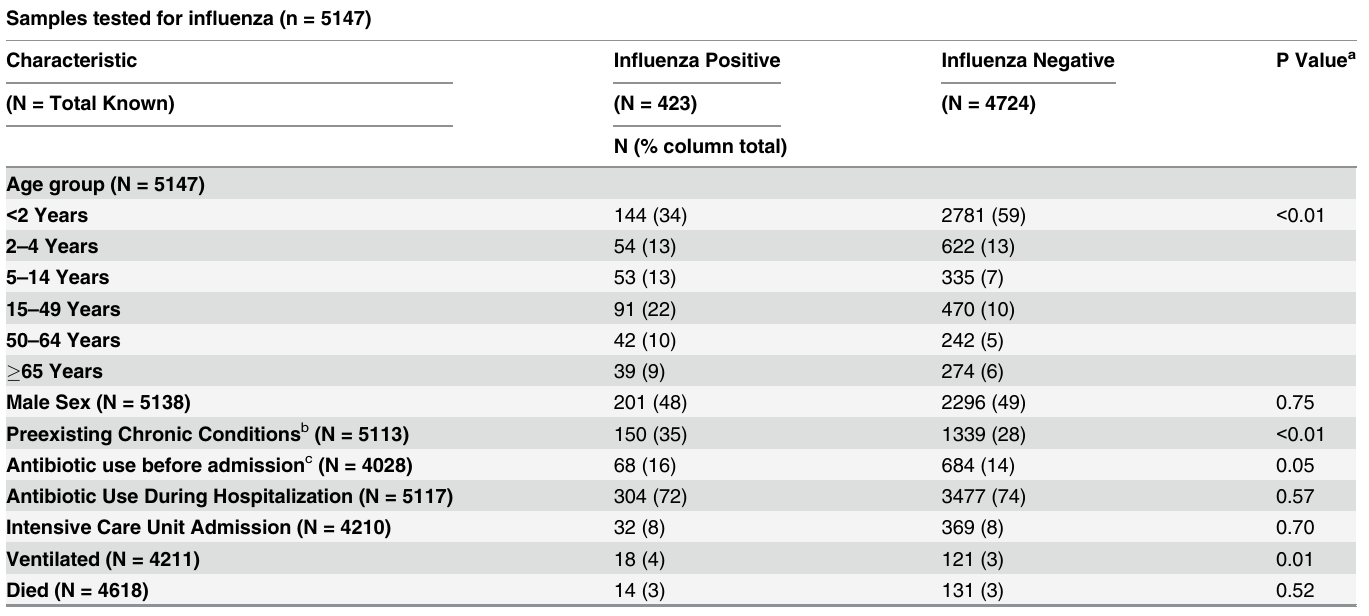
Table 3. Demographic and clinical characteristics of patients enrolled in sentinel surveillance for severe acute respiratory infections by viral influ- enza etiology, Sultanate of Oman, January 2008-June 2013. Samples tested for in fl uenza (n = 5147)